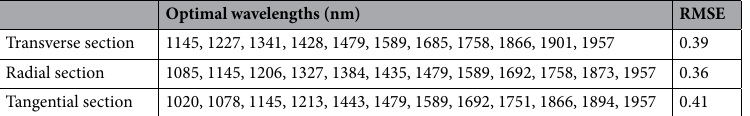
Table 2. Optimal wavelengths of SPA